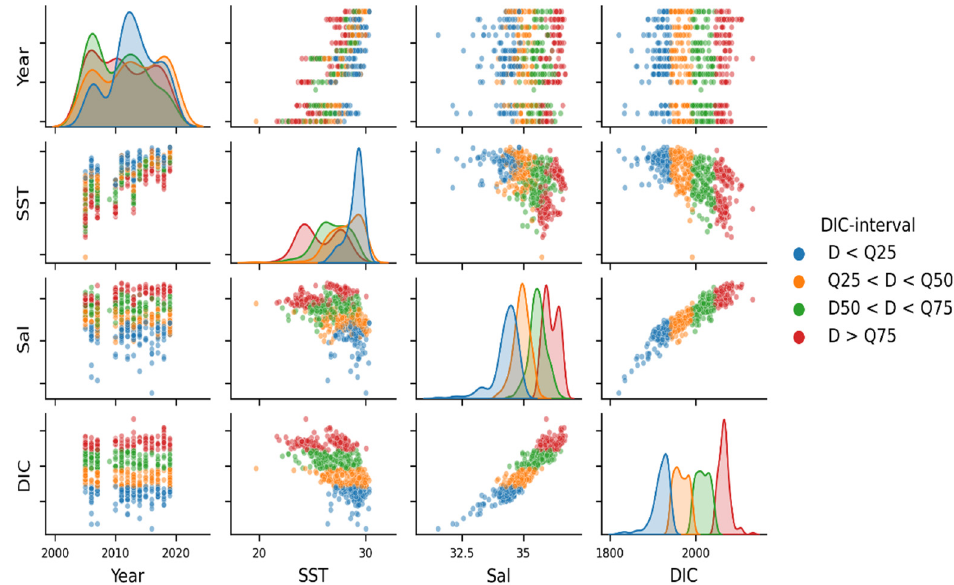
Figure A1. Scatter plots between variables and density plots for each variable (on the main diagonal). Data are colored according to the intervals of the quantiles of DIC (25%, 50%, 75%).